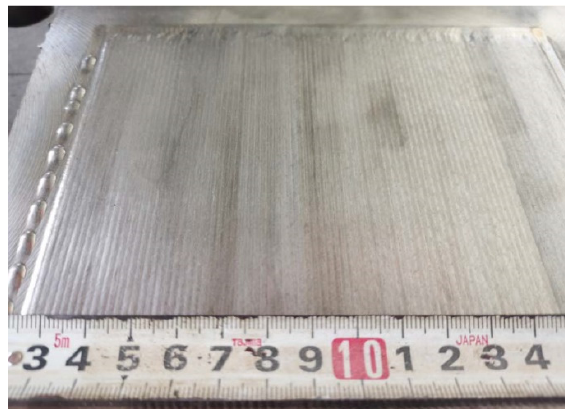
Figure 9. Appearance of the welded plate with upgraded parameters.